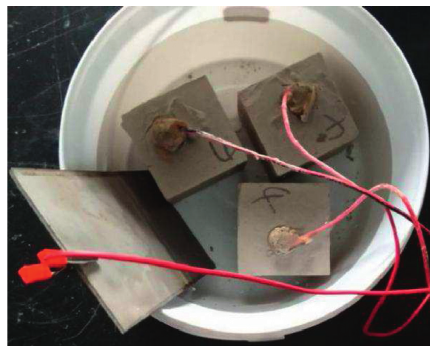
Figure 8: Accelerating the corrosion of the steel